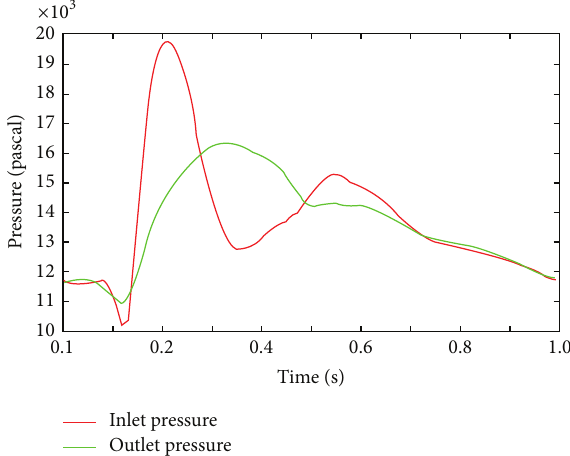
Figure 4: Calculated inlet pressure profile (red) and outlet profile (green) for pressure fixed